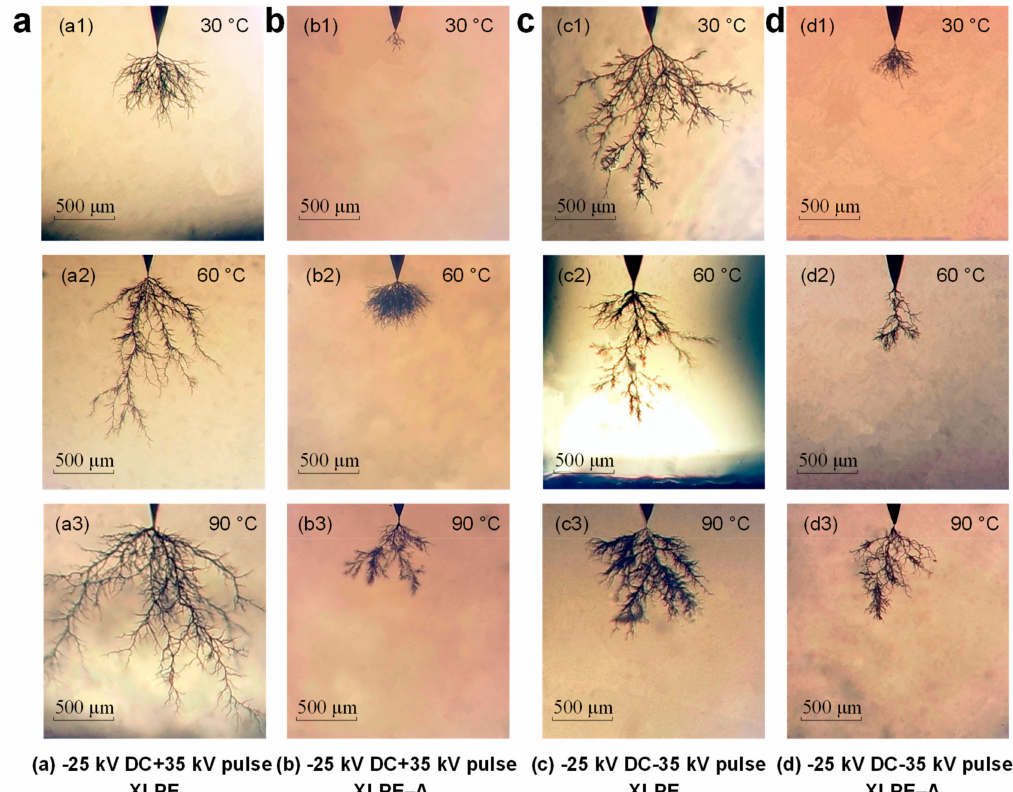
Figure 3. The electrical tree structures of the neat cross-linked polyethylene (XLPE) and XLPE − A